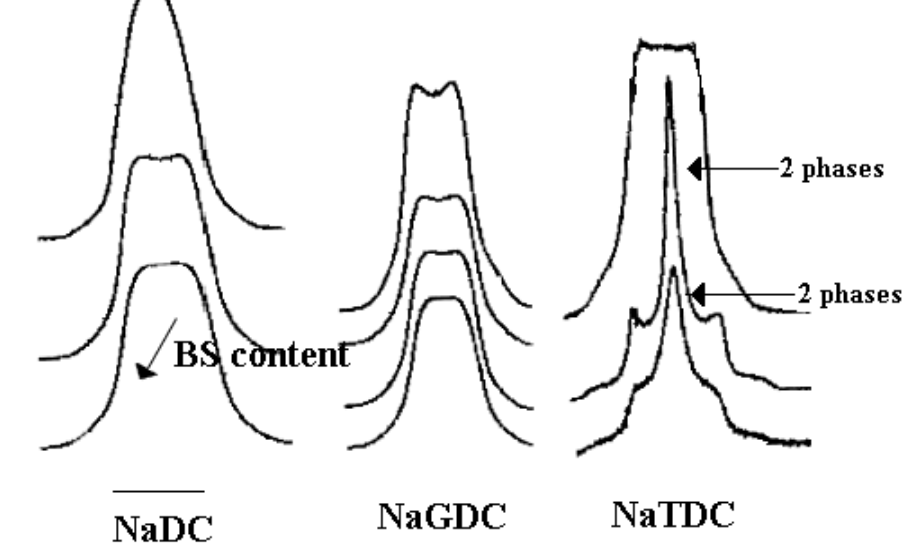
2 H-NMR spectra of different liquid crystalline samples, made up of heavy Figure 10. water and different BS , at room temperature. The quadrupole splitting, i.e. the distance between the two upper peaks, can be detected. In the water- NaTDC system the quadrupolar splitting overlaps with an isotropic signal, due to the coexistence of liquid crystalline and solution phases. The 500 Hz wide bar indicates the amplitude of quadrupolar splitting. Spectra relative to NaDC suggest that many chemically different binding sites for heavy water exist. The overall spectrum is originated by the overlapping of many